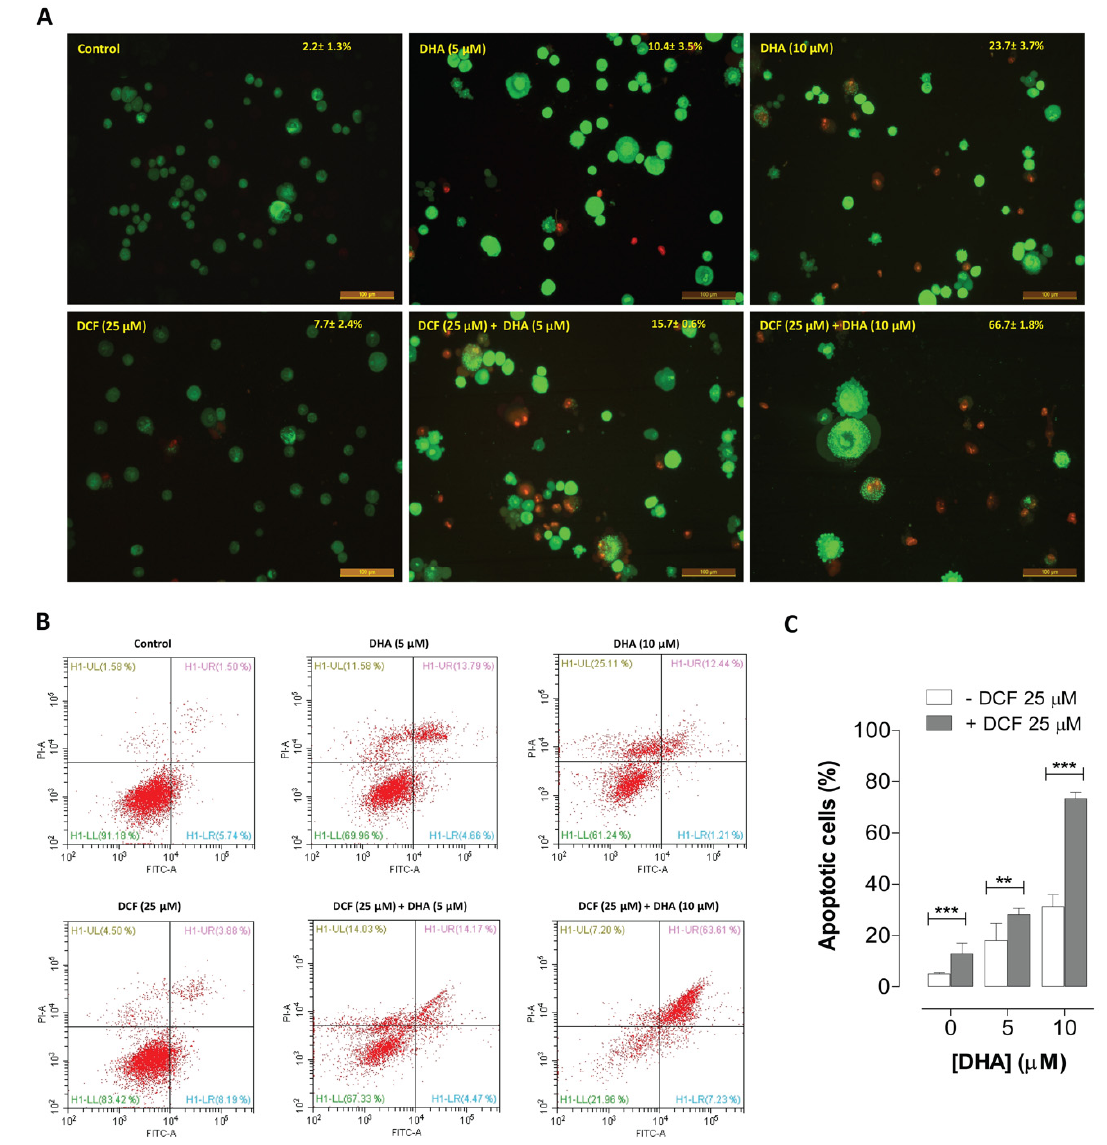
Figure 5. Diclofenac (DCF) increased DHA-induced apoptosis in lung cancer A549 cells. ( A ). Cells treated with DHA and DCF for 48 h were analyzed for apoptosis using acridine orange and ethidium bromide (AO / EB, 10 µ g / ml) as described in the methods. Stained cells were visualized with a Leica DM5000B fluorescent microscope (magnification × 20). When stained with AO / EB, live cells with normal nuclei appear green while apoptotic cells ( A ) with condensed or fragmented chromatin in the nuclei appear orange. ( B ) Representative scatter plots illustrating Annexin V-FITC / PI staining of cells after treatment of A549 cells with DHA (0–10 µ M) and DCF (25 µ M) for 48 h. Annexin-V vs. PI plots were generated via flow cytometry cell sorting technology. The percentage of the apoptotic cell death increased in cells co-treated with DHA and DCF. ( C ). Co-treatment of A549 cells with DHA and DCF resulted in a dramatic increase in the percentage of apoptotic cells (early and late apoptotic cells). Data were expressed as means (± SEM, n = 3). ** p < 0.01; *** p < 0.001 indicate significant differences compared to treatments with DHA alone.